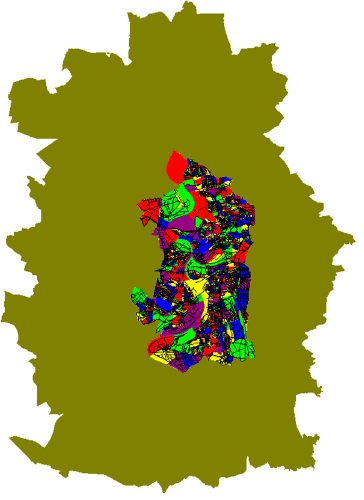
Figure 2. Overall range of the simulated area.